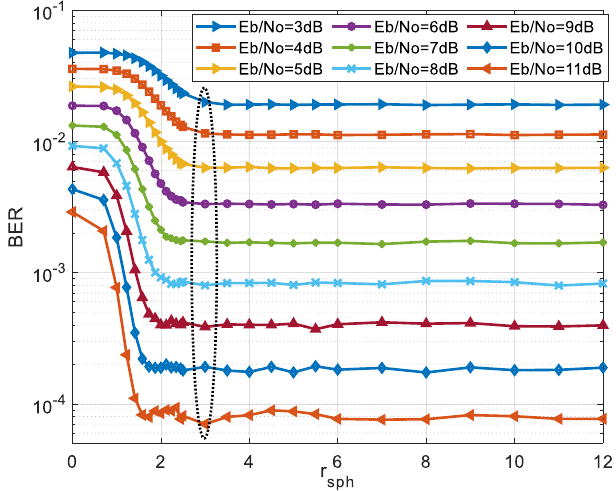
Figure 6. The dependence of BER on r 16 -QAM.